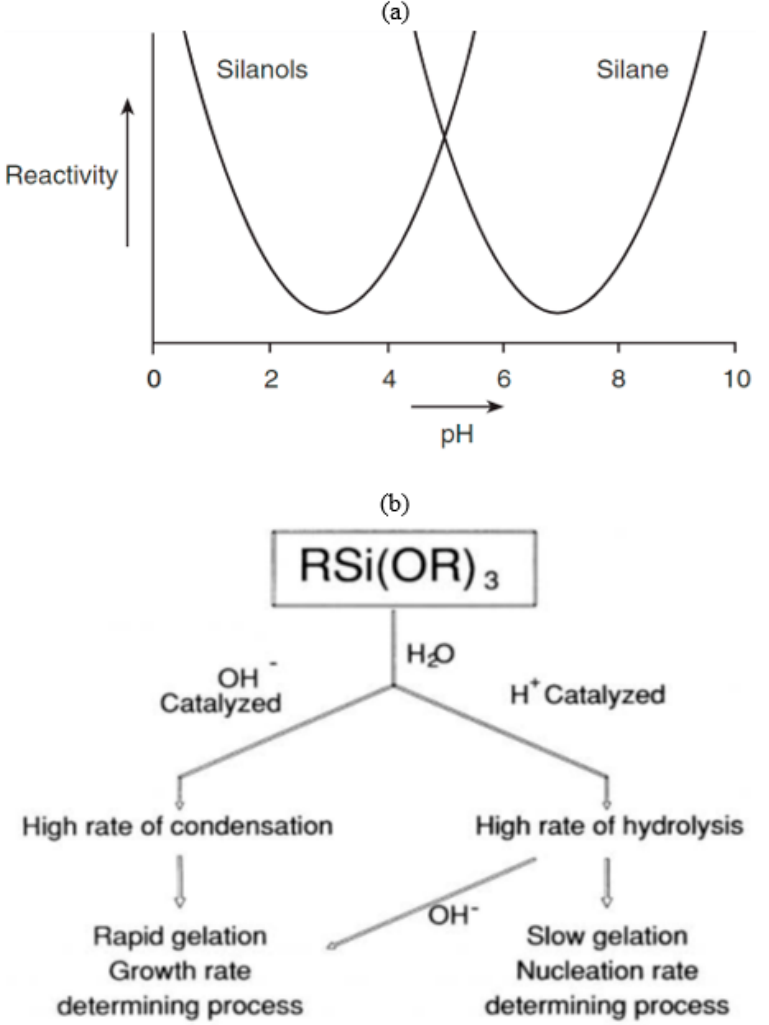
Figure 3. ( a ) Reactivity of silane(s) and silanols. Silanols are most stable at pH around 3, and their reactivity increases when pH is lower than 1.5 or higher than 4.5 [27]. ( b ) Effect of pH on alkoxysilane hydrolysis. The gross changes in silane condensation and polymerization in an acid vs. base condition [19].